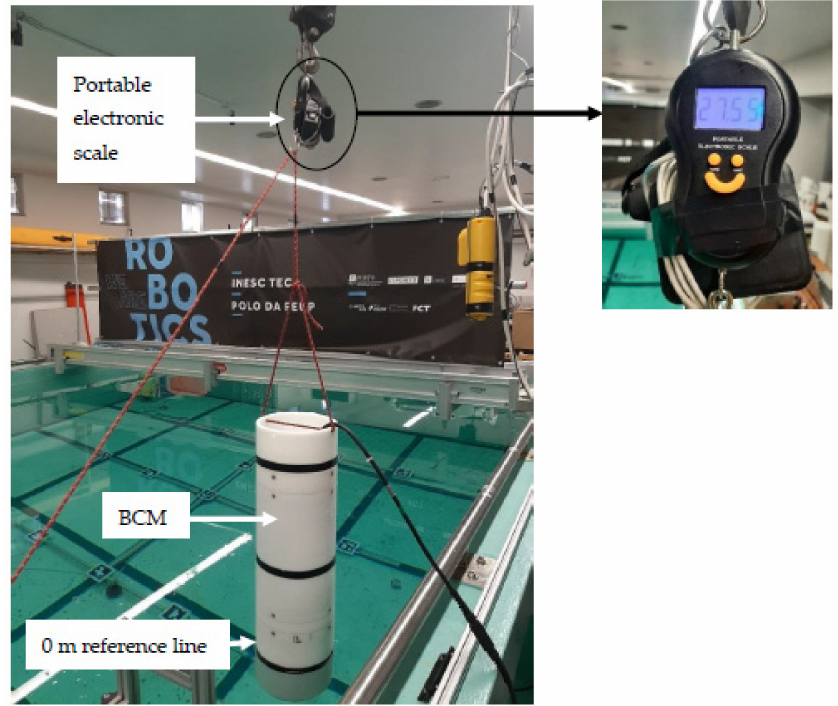
Figure 16. Picture of the experimental